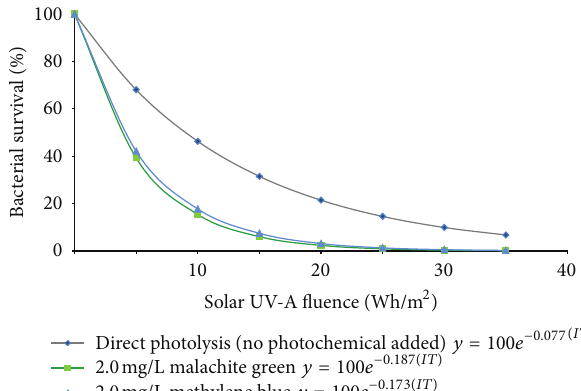
Figure 7: Comparison of bacterial (faecal coliforms) survival as a function of solar UV fluence with direct photolysis and photosensitisers malachite green and methylene blue at 2.0 mg/L concentration.